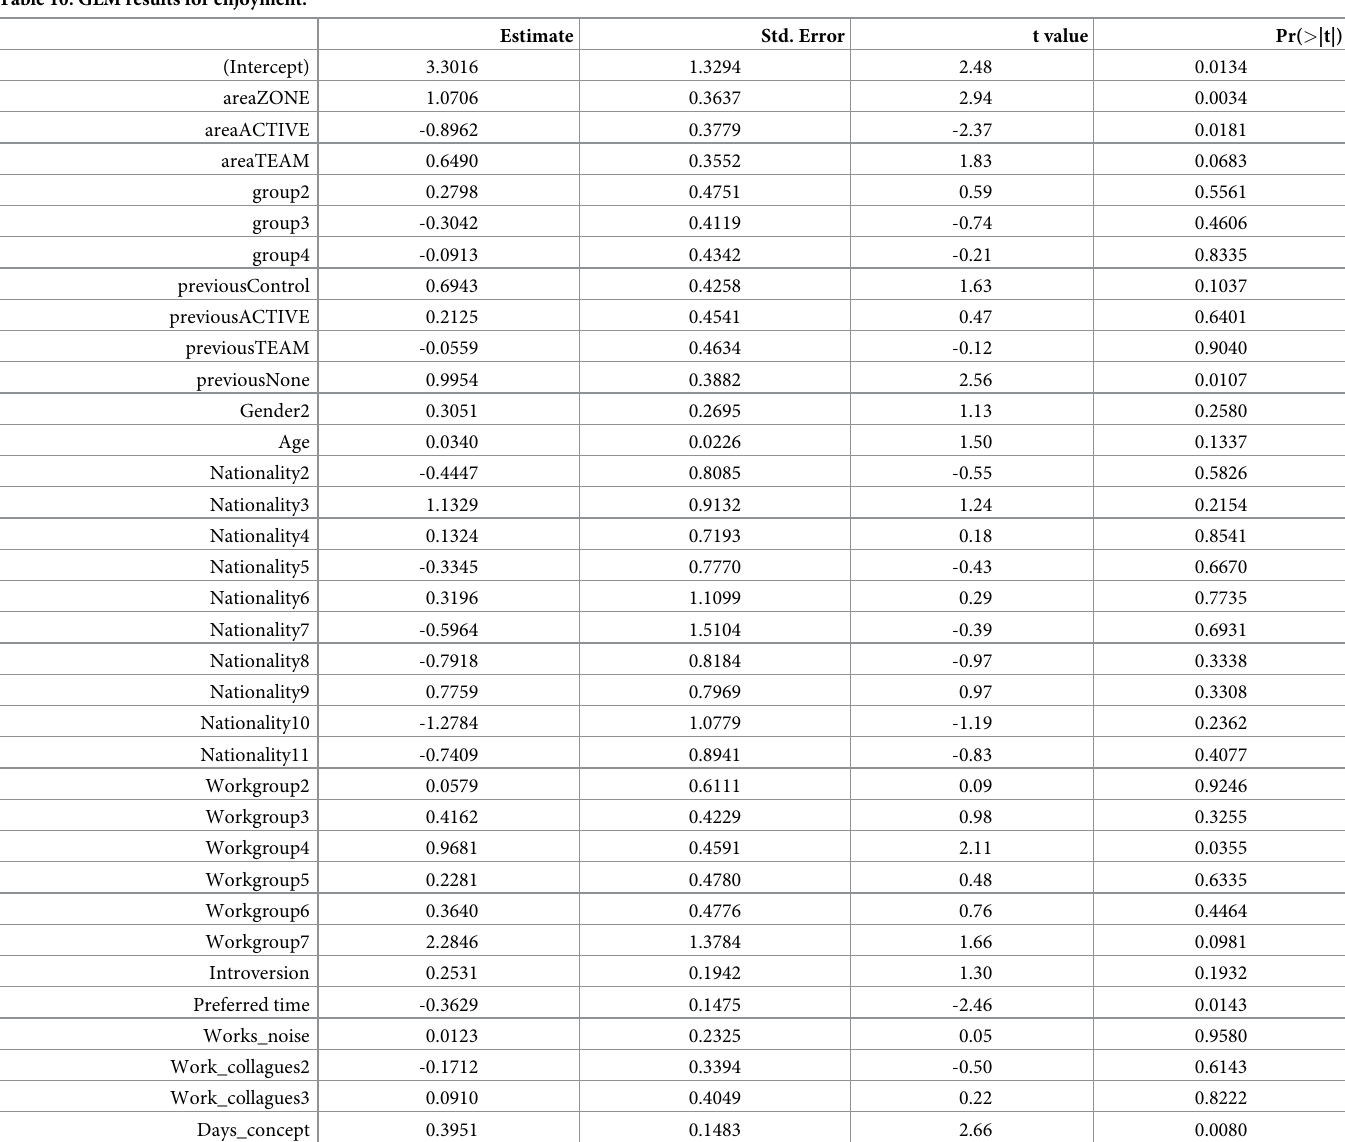
Table 10. GLM results for enjoyment.